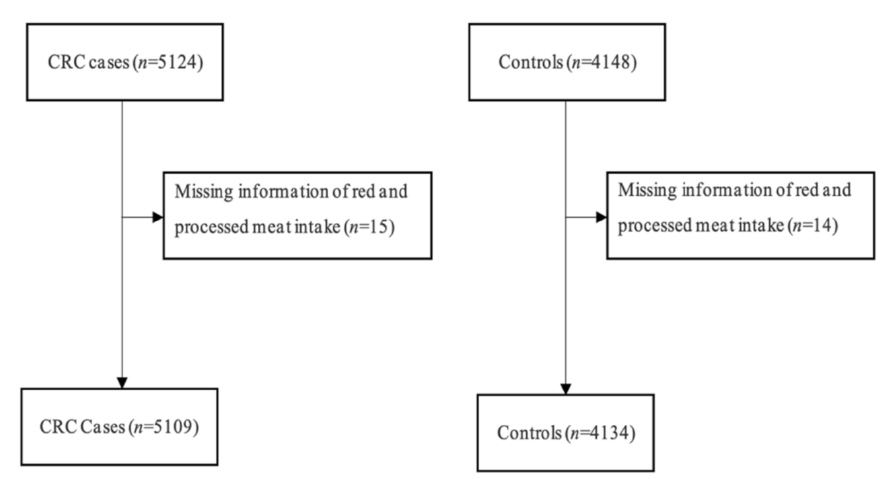
Figure 1. Flowchart of inclusion of study participants. Abbreviation: CRC, colorectal cancer.